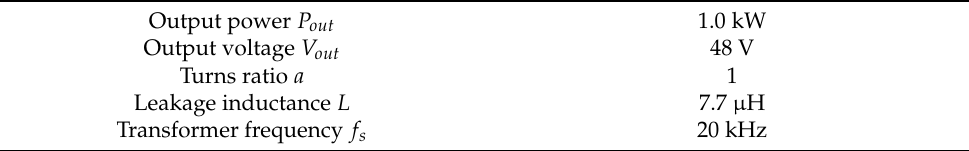
Table 1. Common specifications for conventional SAB and proposed SR–SAB converters on 1 kW output